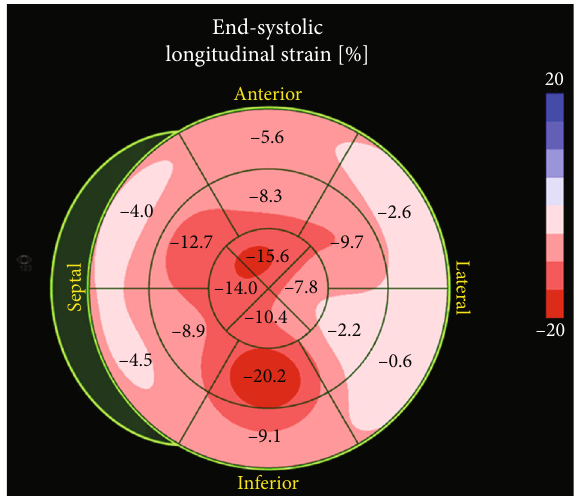
Figure 3: Echocardiographic strain analysis showing a relative sparing of the apex compared to the bases.